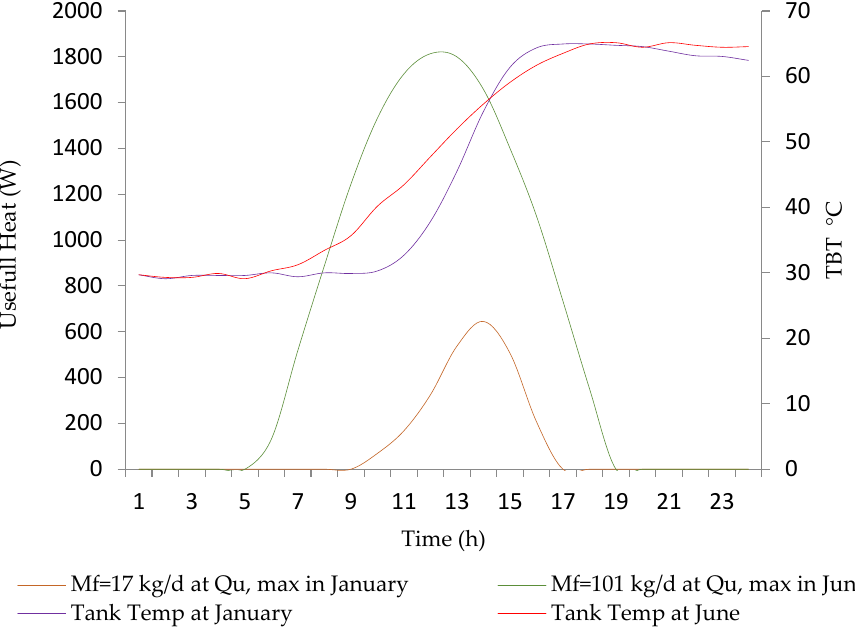
Figure 5. Calculated useful solar heat and feed water temperature in the storage tank.